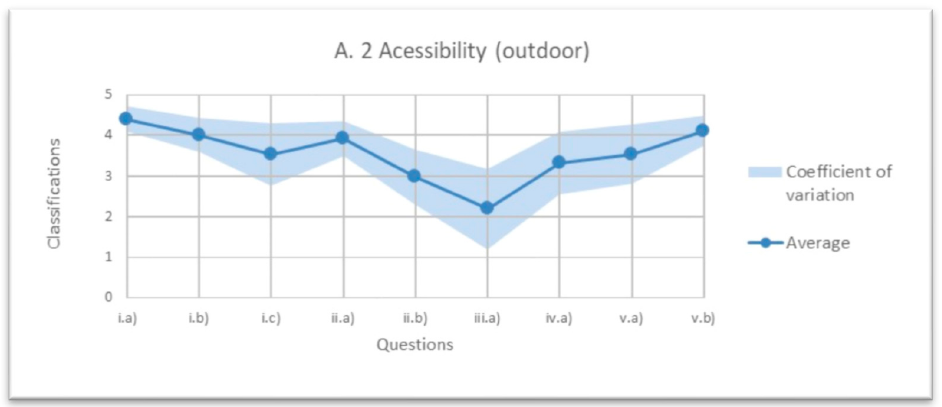
Figure 9. Average ratings of accessibility.